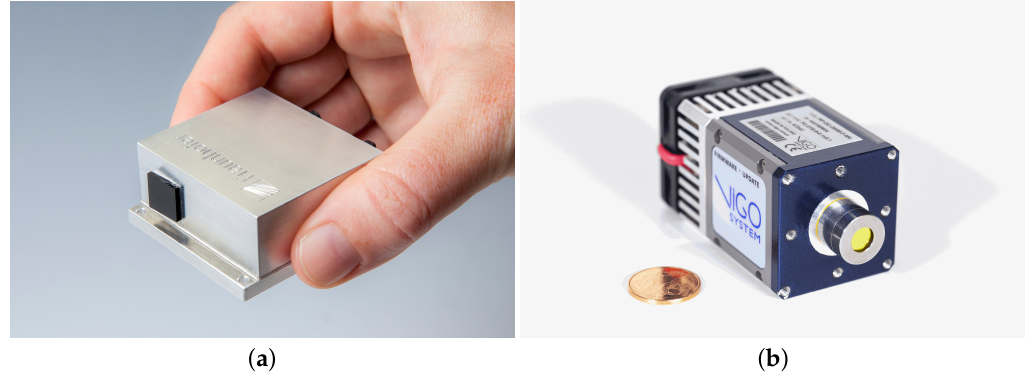
Figure 4. Photographs showing ( a ) the compact design s of the external cavity quantum cascade laser (EC-QCL) with micro-opto-electro-mechanical system (MOEMS) di ff raction grating and ( b ) the high operating temperature (HOT) T2SL IR detector from Fraunhofer IAF in a detector module